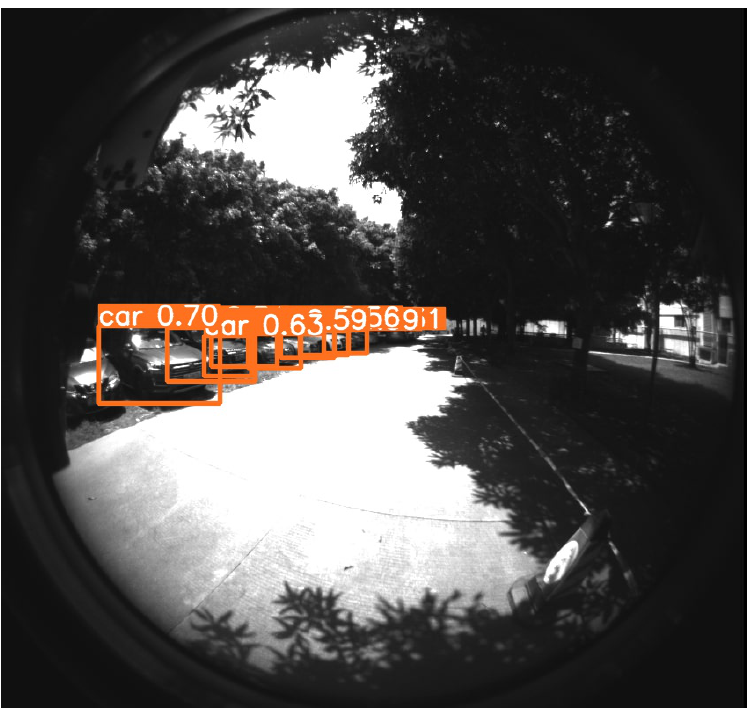
Figure 11. The ordinary car-detection